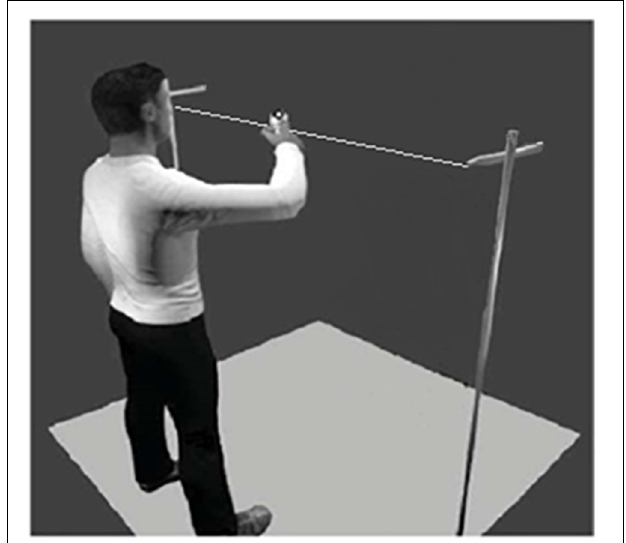
FIGURE 1 | Experimental device showing one participant engaged in the improvizational motor task (i.e., the adapted Mirror Game, cf. Noy et al.,